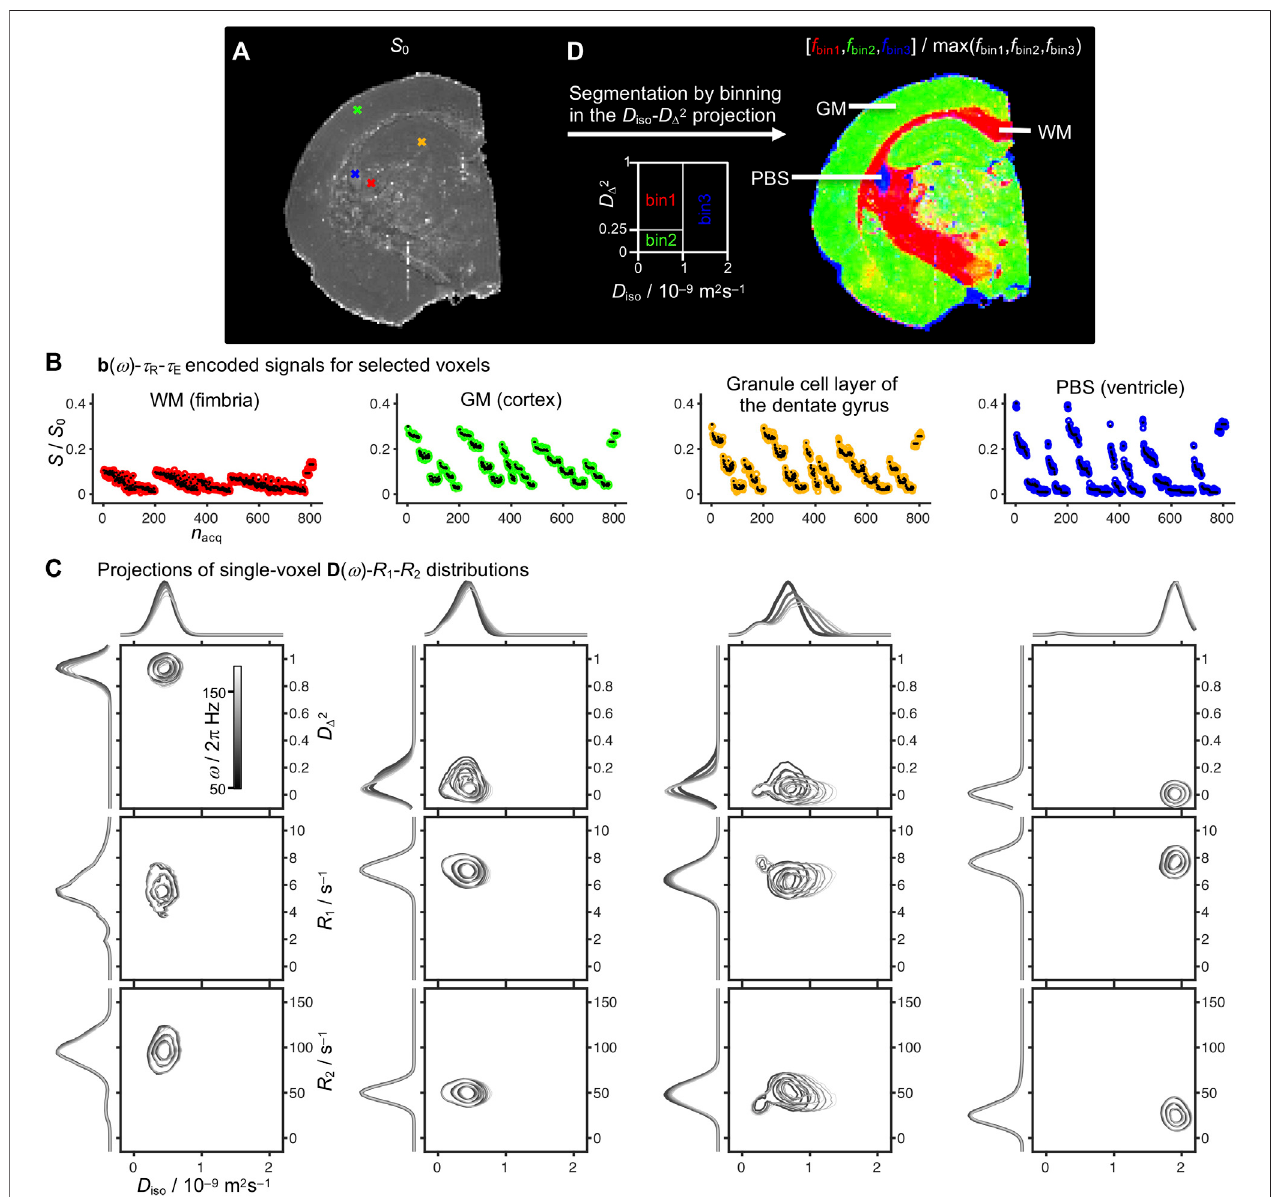
FIGURE 2 | Experimental results for representative voxels in an ex vivo rat brain and tissue segmentation by binning. (A) S 0 map with crosses indicating single voxelsrepresentative for white matter (WM) in the fi mbria(red), gray matter (GM) in the cortex(green), the granule cell layer of the dentate gyrus (orange), and phosphate buffer saline (PBS) in the ventricle (blue). (B) Single-voxel signals S as a function of acquisition index n acq according to the 7D b ( ω )- τ R - τ E scheme in Figure 1 (colored circles: experimental; black dots: back-calculated from the distributions). The values of S 0 correspond to the signals extrapolated to b (cid:2) 0, τ R (cid:2) ∞ , and τ E (cid:2) 0. (C) D ( ω )- R 1 - R 2 distributionsforeachoftheselectedvoxelsprojectedontothe2D D iso - D Δ 2 , D iso - R 1 ,and D iso - R 2 planesfor fi vefrequenciesintherange ω /2 π (cid:2) 50 – 150 Hzas indicated with the linear gray scale of the contour lines. (D) Tissue segmentation by binning in the 2D D iso - D Δ 2 projection at the frequency ω /2 π (cid:2) 50 Hz, resulting in per- bin signal fractions f bin1 (red), f bin2 (green), and f bin3 (blue) aiming to capture the spatial distributions of WM, GM, and